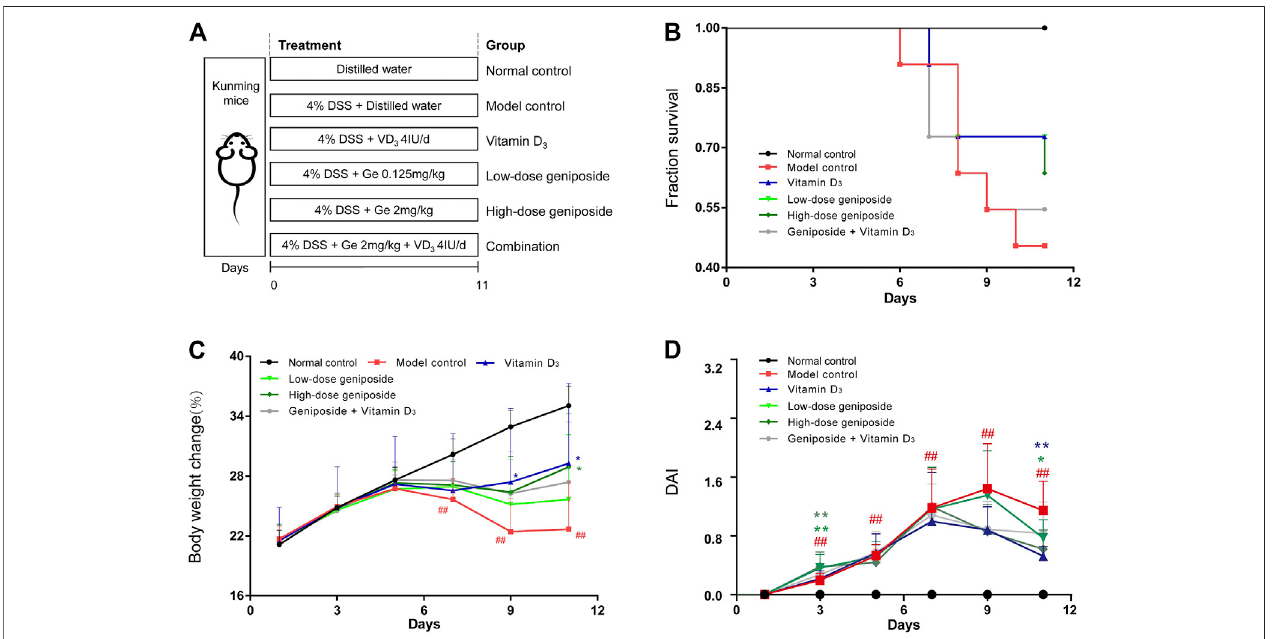
FIGURE 1 | Combination of vitamin D 3 and geniposide exerted less bene fi cial effects on improving the symptoms and the survival of UC mice. (A) Experimental design protocol. (B) Survival curve. (C) Body weight change. (D) Disease activity index. # p < 0.05, ## p < 0.01, vs. the normal control group; * p < 0.05, ** p < 0.01, vs. the model control group. n (cid:1) 11 per each